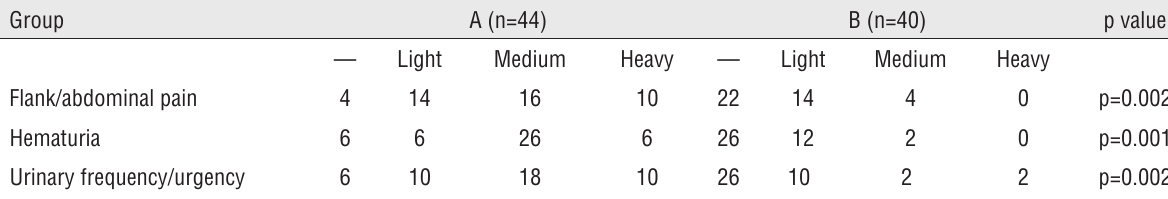
Table 3 - Comparison of postoperative